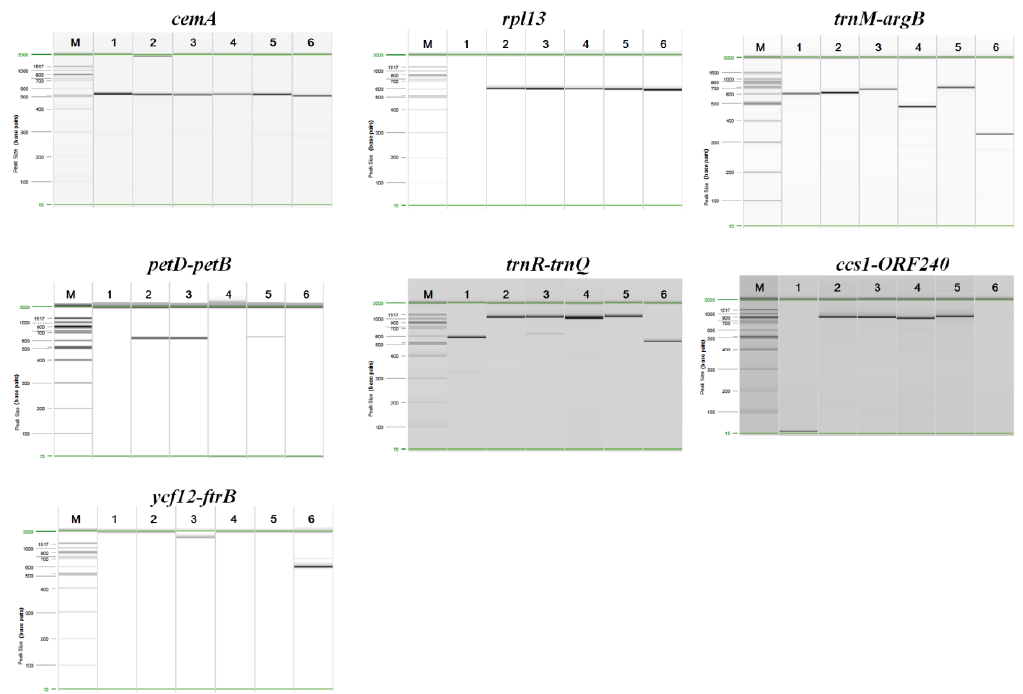
Figure 3. Gel profiles of fragments amplified from six species using seven pairs of primers derived from hypervariable regions of seven Pyropia chloroplast genomes. M indicates the lane containing the molecular weight marker. The numbers correspond to the species listed in Table 2.